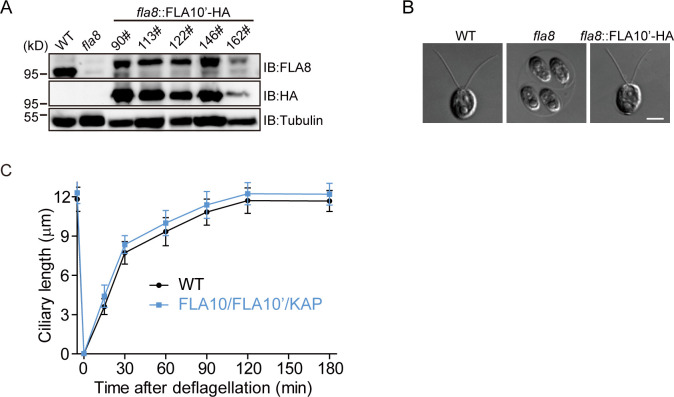
Cells expressing chimeric CrKinesin-II with identical motor domains of FLA10 form normal cilia.(A) HA-tagged FLA10’ (motor domain of FLA10 with FLA8 carboxyl tail) was transformed into an aflagellate mutant fla8. The transformants were expected to form a chimeric motor with two identical motor domains of FLA10. The transformants were examined by immunoblotting with wild type (WT) and fla8 cells as control. (B) FLA10’ rescued the aflagellate phenotype of fla8. Shown are the differential interference contrast images of the cells as indicated. Bar, 5 μm. (C) Ciliary regeneration kinetics of FLA10’ transgenic strain with wild type cells as a control. The cells were deflagellated by pH shock to allow ciliogenesis. Ciliary length of the cells was measured before deflagellation or at the indicated times after deflagellation. Data shown are mean ± SD (n = 50).